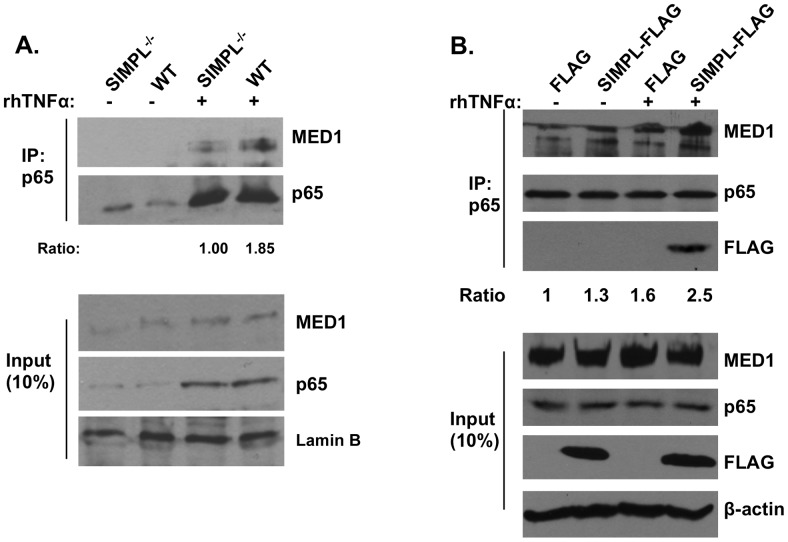
SIMPL enhances p65-MED1 complex formation.(A) MEFs derived from littermate controls (WT) or SIMPL−/− mice were left untreated (-) or were treated with rhTNFα (10 ng/ml) for 45 minutes. Upper panel: nuclear extracts were subjected to immunocomplexing assays with p65 antibody and immunocomplexed materials were subjected to Western analysis with antibodies to the indicated proteins. Lower panel: Western analysis of cell lysates (10%; 50 ug) used in immunocomplexing assays with antibodies to the indicated proteins. (B) HEK 293 cells transfected with FLAG-SIMPL or empty FLAG-vector (Flag) and were left untreated (-) or were treated with rhTNFα (10 ng/ml; 45 min). Upper panel: immunocomplexing assays performed with p65 antibody were subjected to Western analysis with antibodies to the indicated proteins. Lower panel: Western analysis of cell lysates (10%; 50 ug) used in immunocomplexing assays with antibodies to the indicated proteins. n = 3.